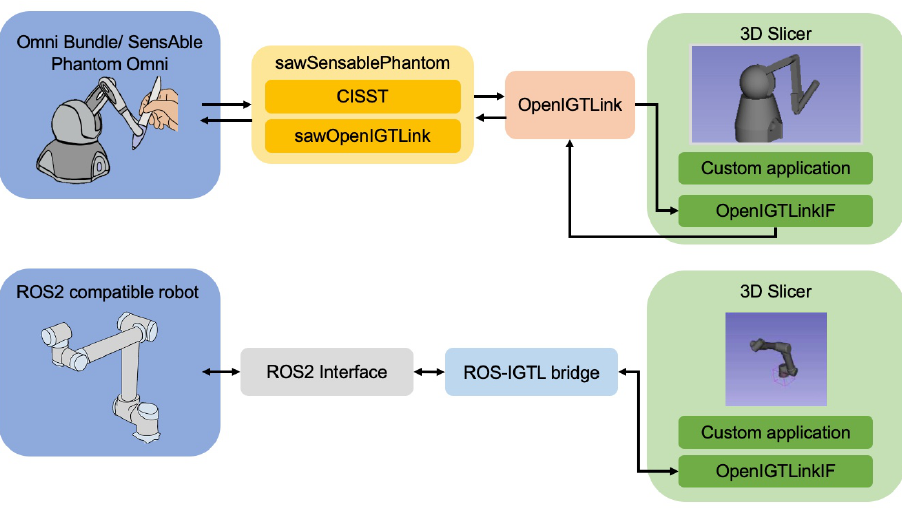
Figure 5. Detailed overview of previous implementations. ( Top ) OmniIGT platform [24] demon- strates the use of a custom application. ( Bottom ) ROS-IGTL bridge demonstrates the use of the more general bridge infrastructure